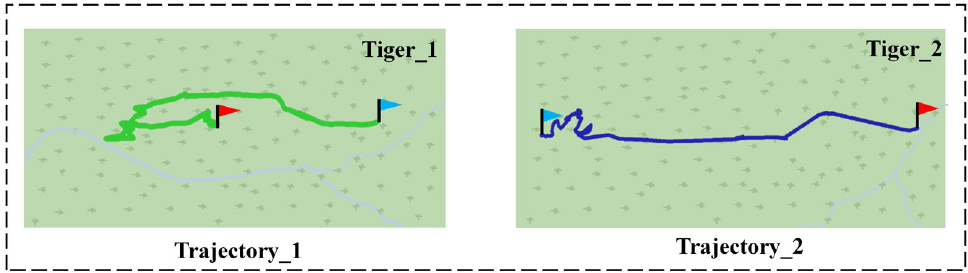
Figure 7. Tracks 1 and 2 are the respective tracks recorded for two tigers, with the red flag representing the starting point and the blue flag representing the endpoint.